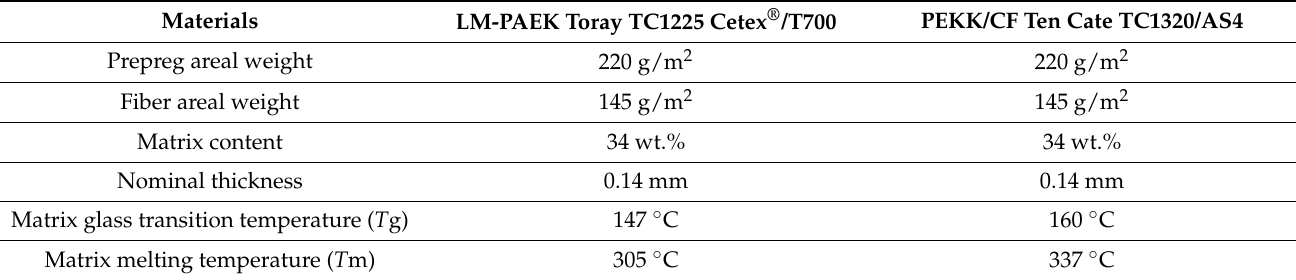
Table 1. Description of UD prepregs (used in this